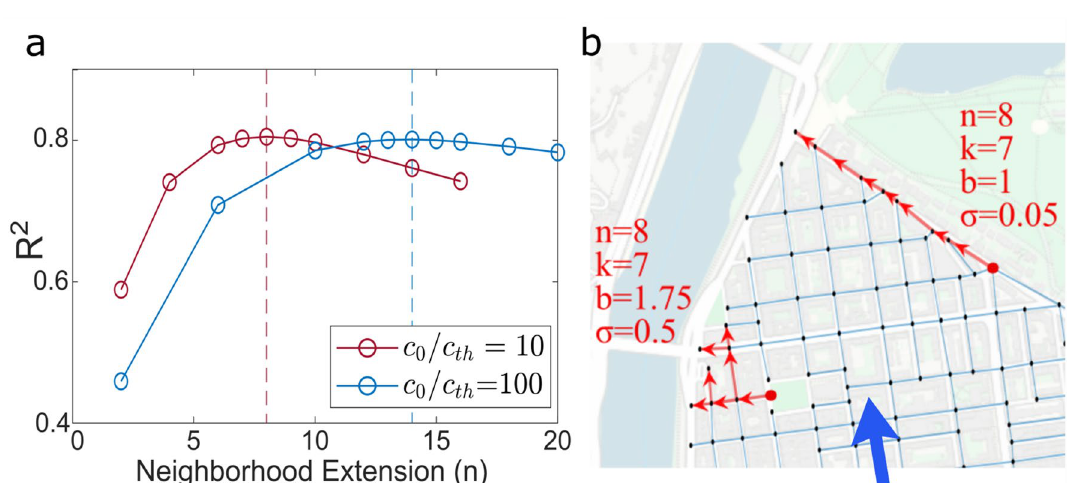
Figure 6. Topological indicators. (a) Coefficient of determination for the regression model as a function of the extension of the node neighborhood for two concentration scenario: c 0 / c th = 10 and c 0 / c th = 100 . (b) Estimate of the topological parameters ( k , b , σ ) for two different nodes of the street network in Lyon, in the same wind scenario (the orientation of the wind is reported as a blue arrow). Background images made with QGIS 2.18 (https:// qgis.